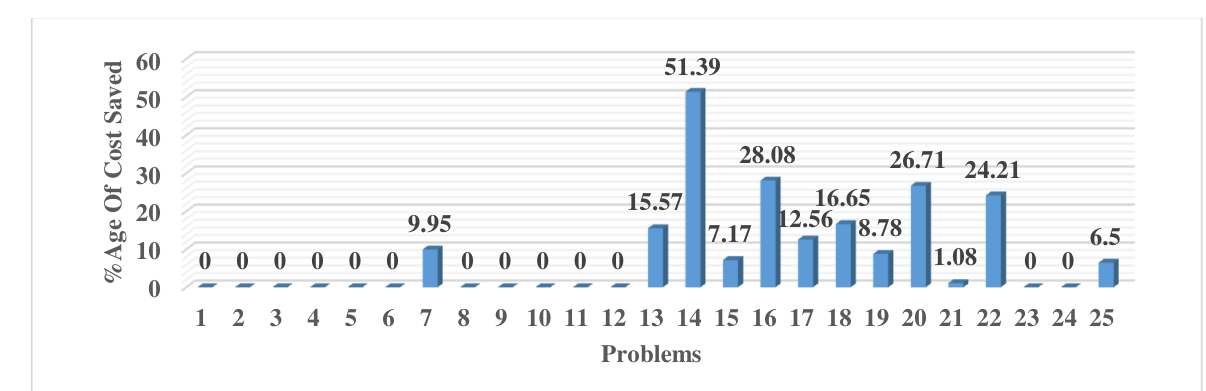
Fig. 7: Comparison in terms of Cost ($)